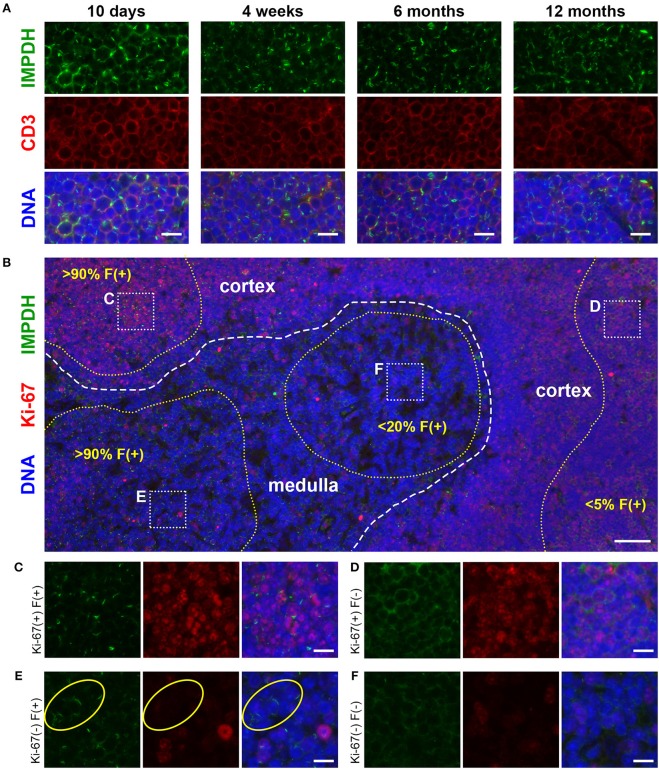
Cortical and medullary thymocytes of young and old mice form IMPDH filaments in vivo. (A) Representative images of FFPE thymuses from 10-days-old, 4-weeks-old, 6-months-old, and 12-months-old healthy B6 mice stained for IMPDH (green) and T cell marker CD3 (red). Widespread consistent IMPDH filament formation was observed in a majority of cells throughout the thymuses of mice at all ages. (B) Representative image demonstrating areas of the thymus with varying levels of IMPDH (green) filament formation and Ki-67 (red) expression. The dashed white line approximates the boundary between the cortex and medulla. As examples, percentage of cells with IMPDH filaments is written within areas outlined by yellow dotted lines. Ki-67 expression is clearly more prevalent in the cortex compared to medulla, as expected. Dotted white boxes labeled (C–F) correspond to C-F below. (C–F) Higher magnification images taken of the areas outlined in (B). These representative images demonstrate four different cell populations in the thymus: (C) Ki-67-positive, filament-positive, (D) Ki-67-positive, filament-negative, (E) Ki-67-negative, filament-positive, and (F) Ki-67-negative, filament-negative. Yellow circles in (E) highlight the filament formation in Ki-67-negative cells. Counterstain for all panels: DAPI (blue). Scale bars: 10 μm (A,C–F), 50 μm (B).